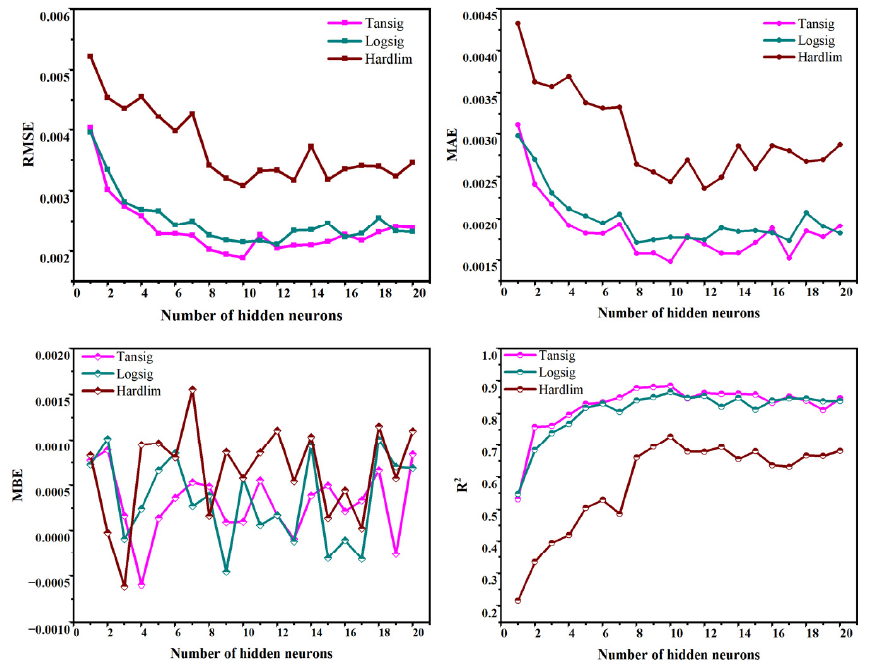
Figure 9. Statistical performance of the BPNN model with different transfer functions and hidden neurons in the testing stage.